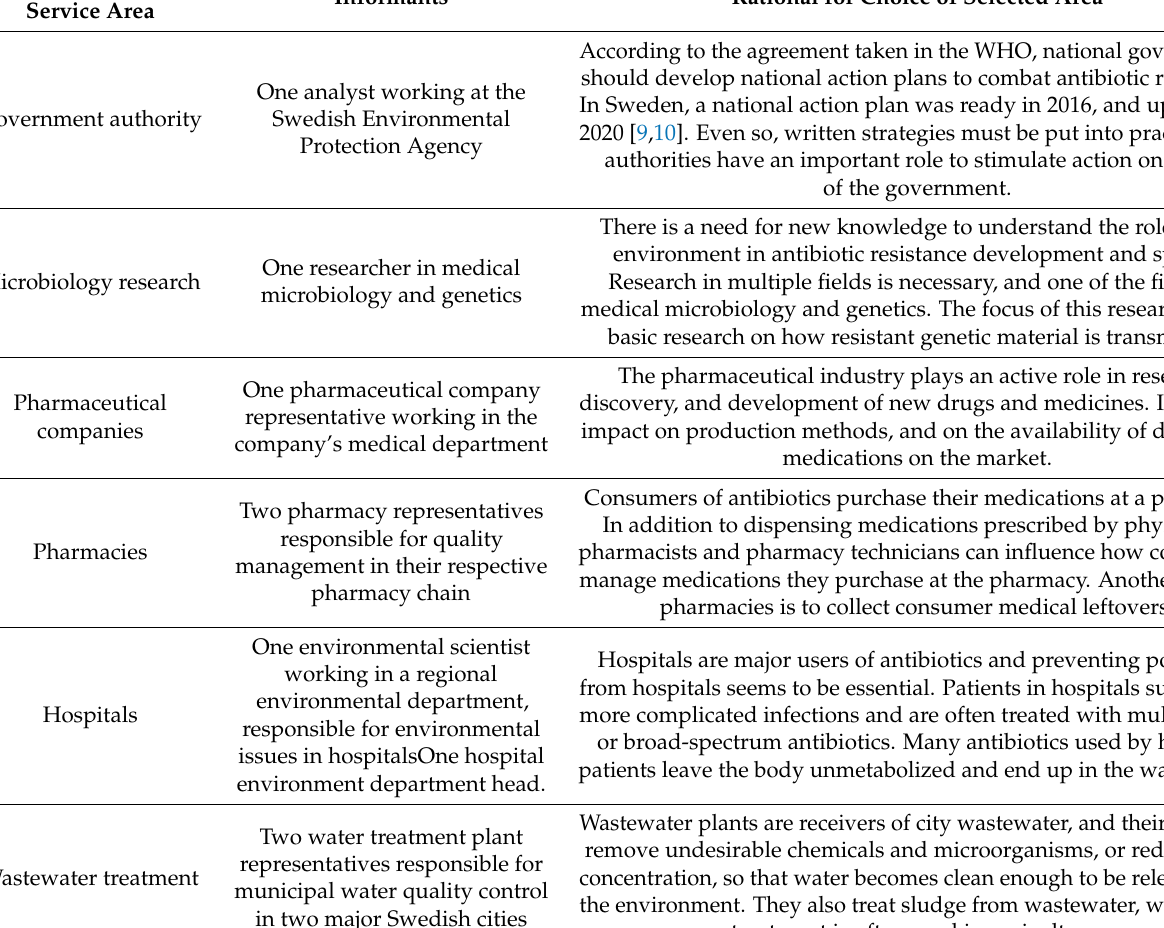
Table 1. The informants and the rational for choosing the selected area of